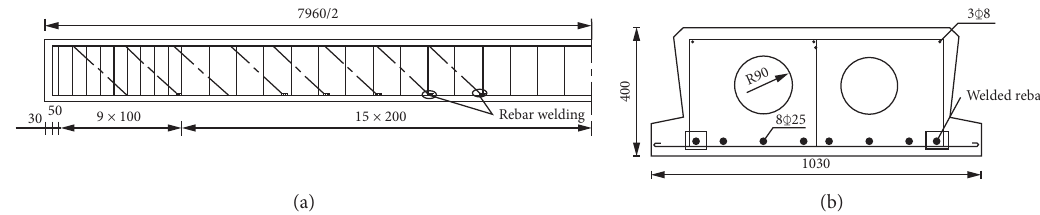
Figure 2: Dimensions and reinforcement of tested beams: (a) longitudinal section reinforcement (half span) (unit: cm); (b) cross section (unit: mm).